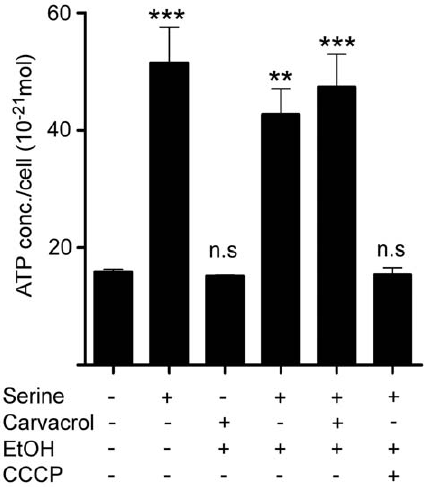
Figure 4. Effect of carvacrol on C.jejuni ATP levels. C. jejuni strain 108 grown in HI broth (16 h) was resuspended in HEPES buffer with or without the indicated supplements. After 2 h incubation at 37 u C under microaerophilic conditions, bacterial ATP levels were determined. Results are expressed as the ATP concentration per bacterium and are mean values 6 standard error from three independent experiments. ** p # 0.005; *** p # 0.001; n.s. not statistically significant.